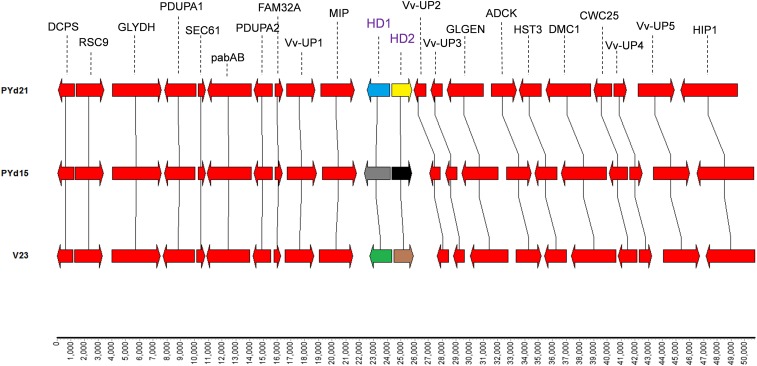
CHROMOMAPPER (Niculita-Hirzel and Hirzel 2008) comparison of genomic regions containing the MAT-A locus from V. volvacea strains PYd21, PYd15, and V23-1, showing the MAT-A locus (HD genes in colored arrows, and purple text), and conserved MAT-A locus flanking genes including the mitochondrial intermediate peptidase gene (MIP), the Sec61 complex subunit gene (SEC61), the glycine dehydrogenase gene (GLYDH), and the glycogenin-2β gene (GLGEN). Black lines connect homologous genes (depicted as red arrows). Relative gene positions (scale in bp) are indicated at the bottom.